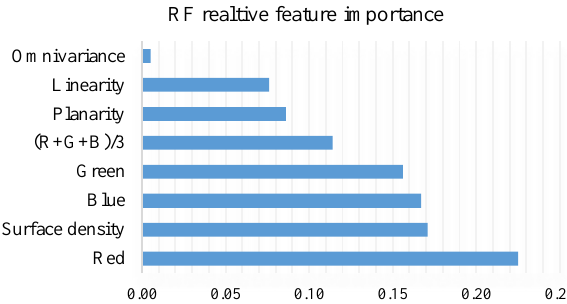
Figure 10. Variable importance obtained by RF classifier.